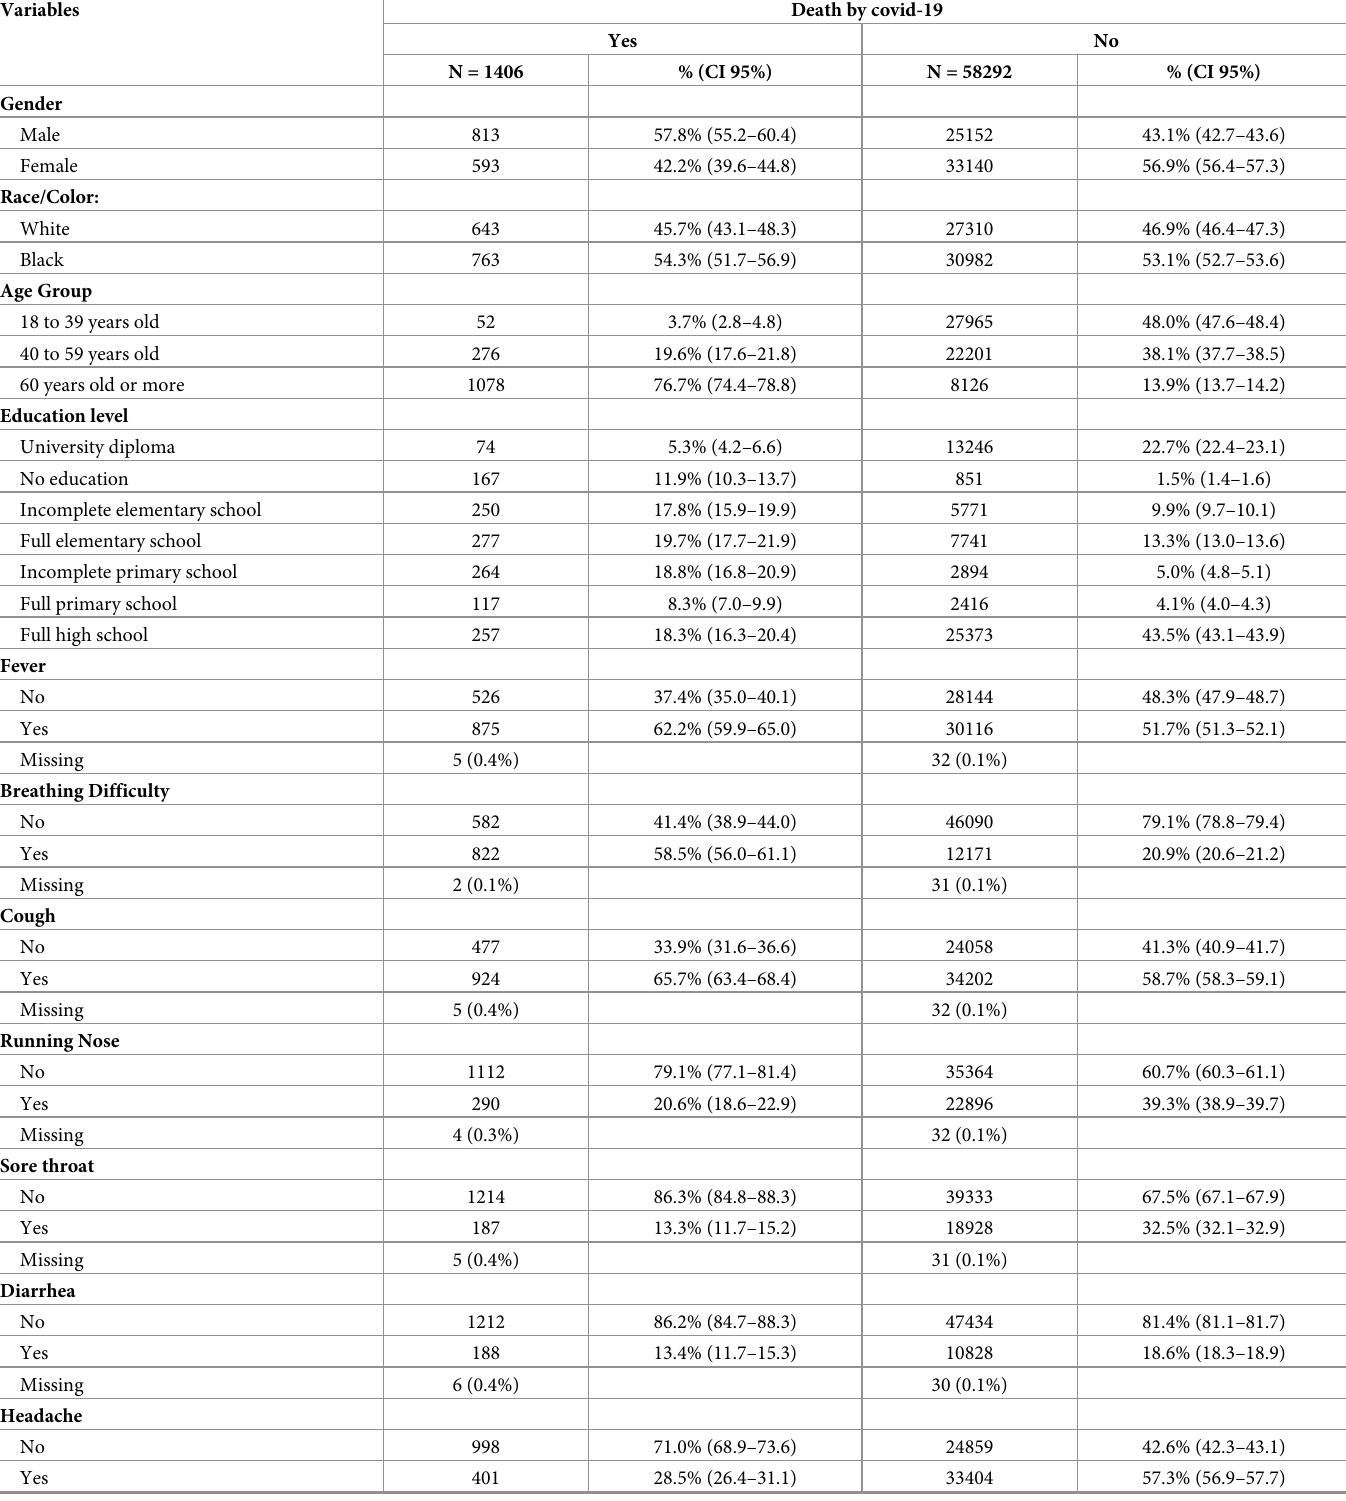
Table 2. Sociodemographic characteristics, comorbidities, and signs and symptoms of confirmed cases that died of COVID-19, Espı´rito Santo, Brazil,